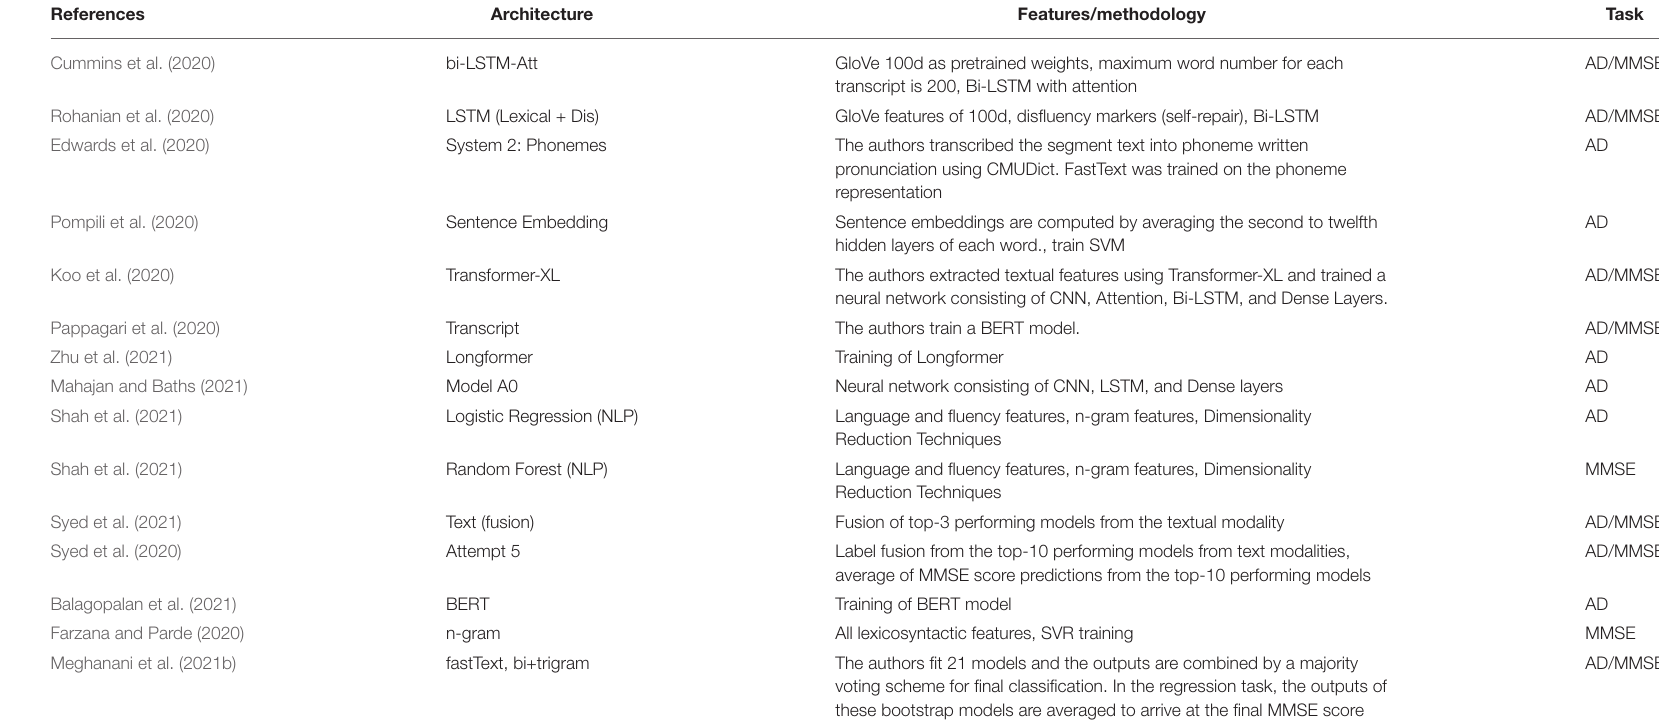
TABLE 2 | Overview of the unimodal state-of-the-art approaches using only text, which are later compared with our